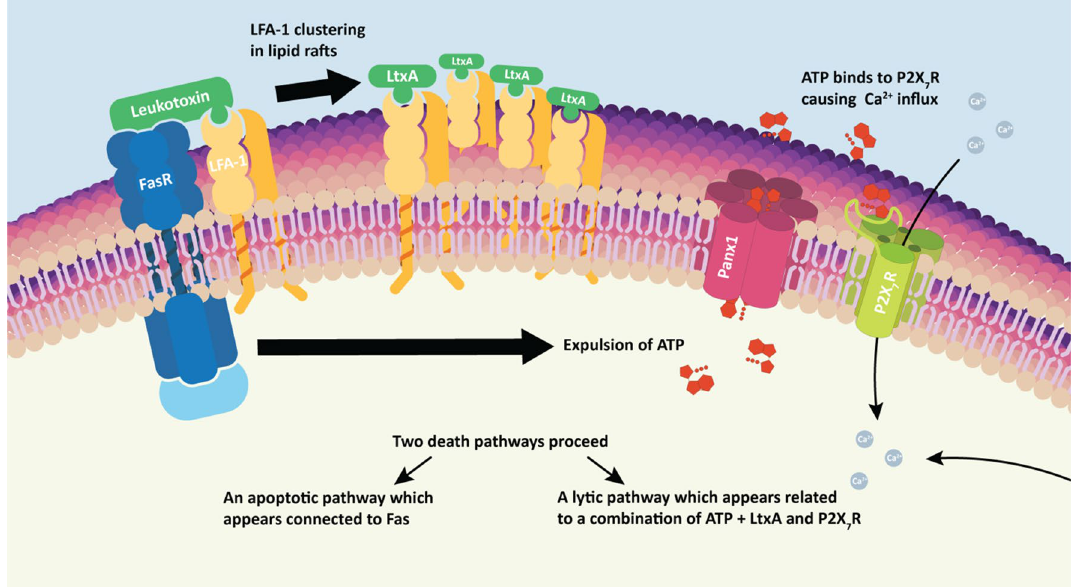
Figure 12. Proposed model. This model describes the proposed molecular sequence of events carried out during the LtxA mediated cell death of Jurkat cells. LtxA first interacts with susceptible cells by binding to LFA-1 which is believed to be coupled to the Fas death receptor. We show in this report that it appears that the next step following LtxA and membrane interaction is the controlled expulsion of ATP via Panx1 channels. The release of ATP then leads to intracellular Ca 2+ mobilization, clustering of LFA-1 into lipid rafts, and subsequent cell death via apoptosis and necrosis. We additionally show that the elevations in intracellular Ca 2+ appear to be dependent on ATPs interaction with the P2X 7